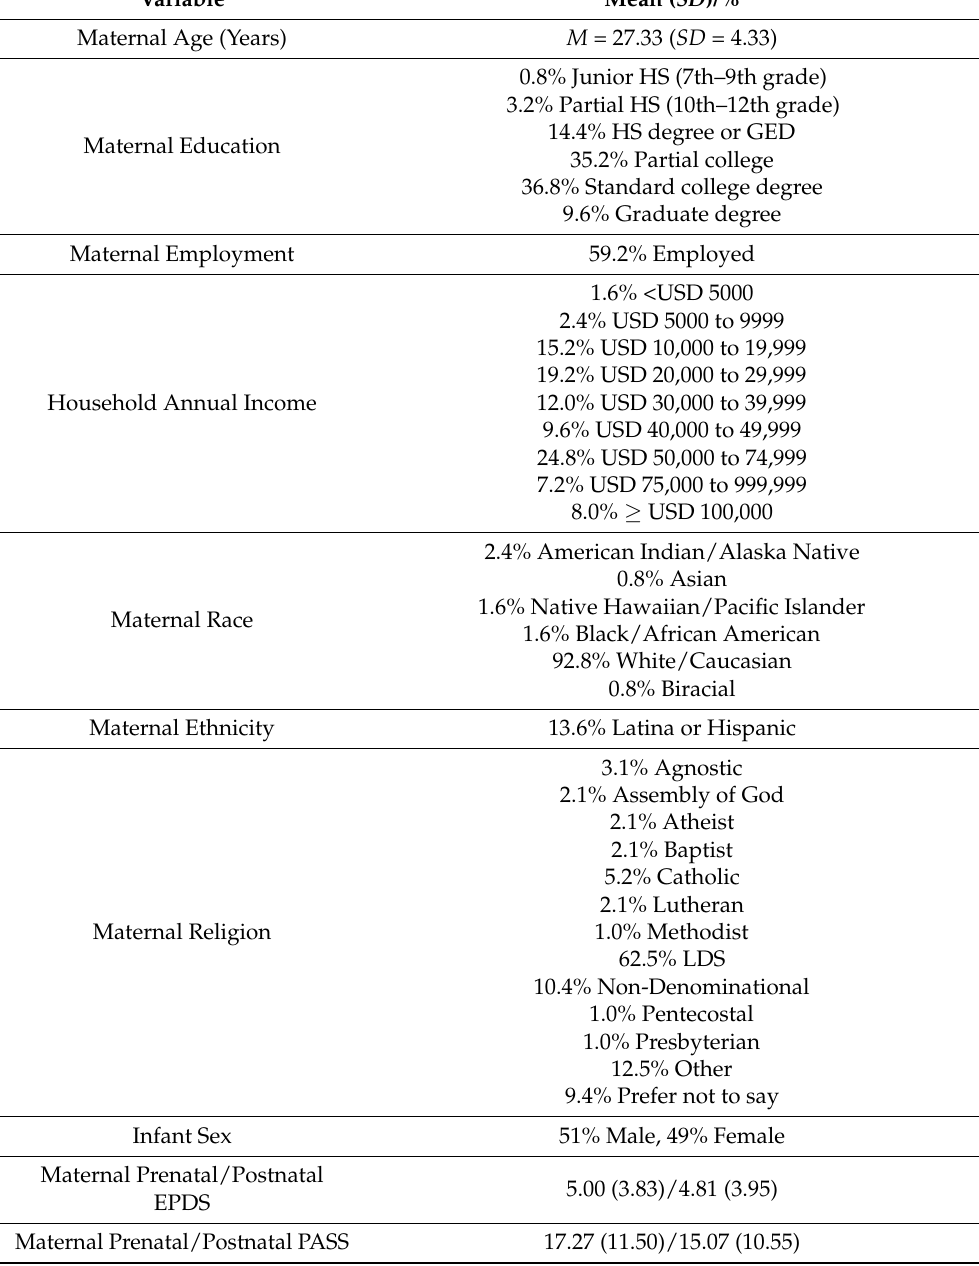
Table 1. Maternal demographics, infant sex, and primary variable